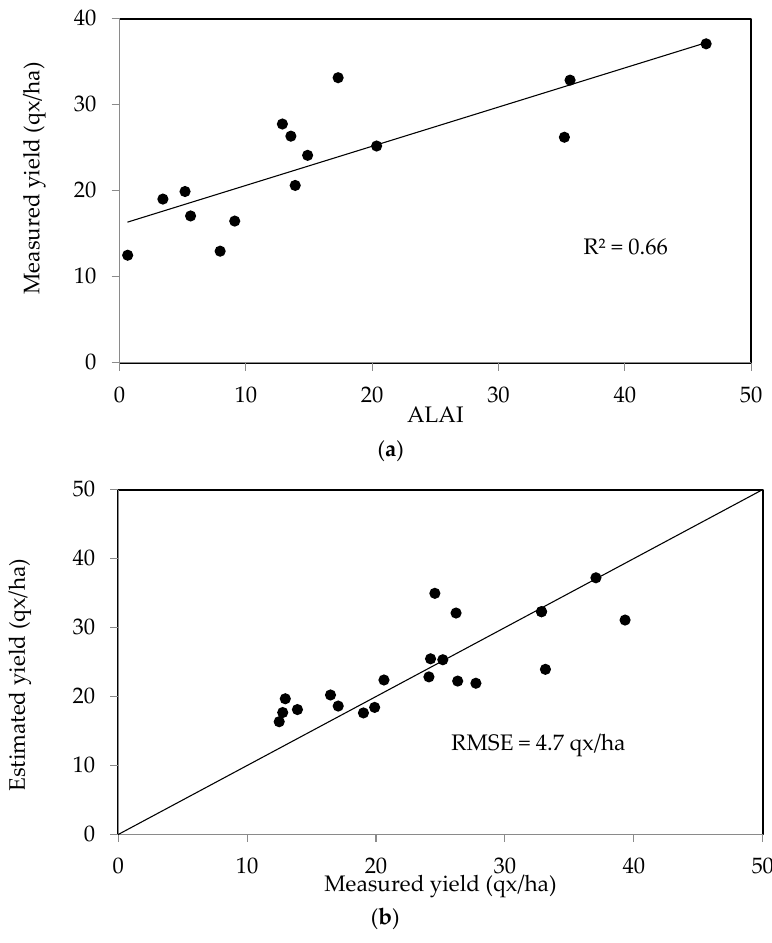
Figure 11. ( a ) Relationship between the grain yields of non-irrigated cereals and LAI during the period of maximum growth; ( b ) Measured yields in non-irrigated test plots, compared with the estimated values computed using the maximum growth LAI over two crop years.